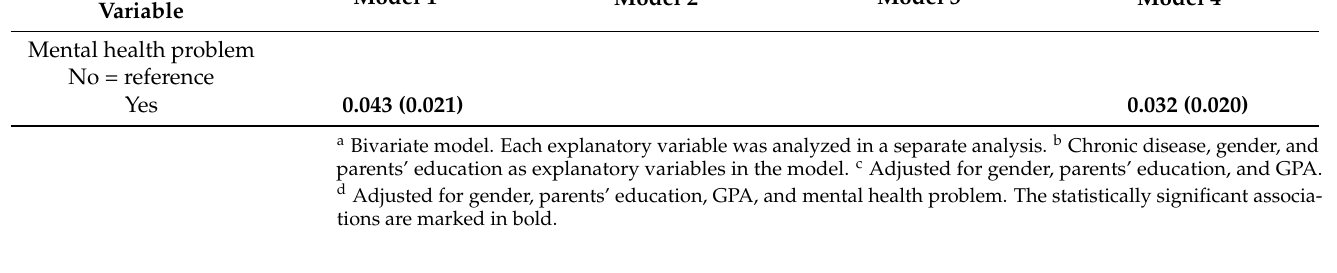
Table A7. The delayed start of upper-secondary school: the analyses of the logistic models of Table 5 presented as average marginal effects. Standard deviations in